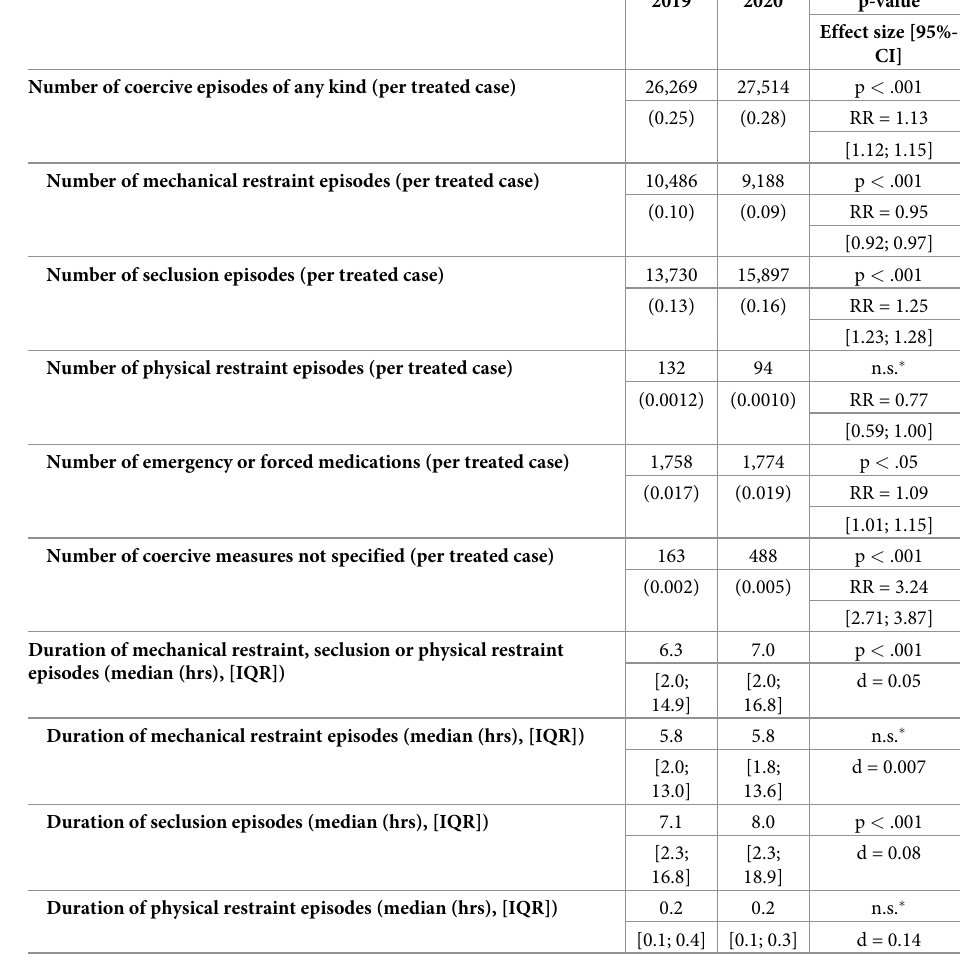
Table 2. Number and duration of coercive episodes in 2020 compared to